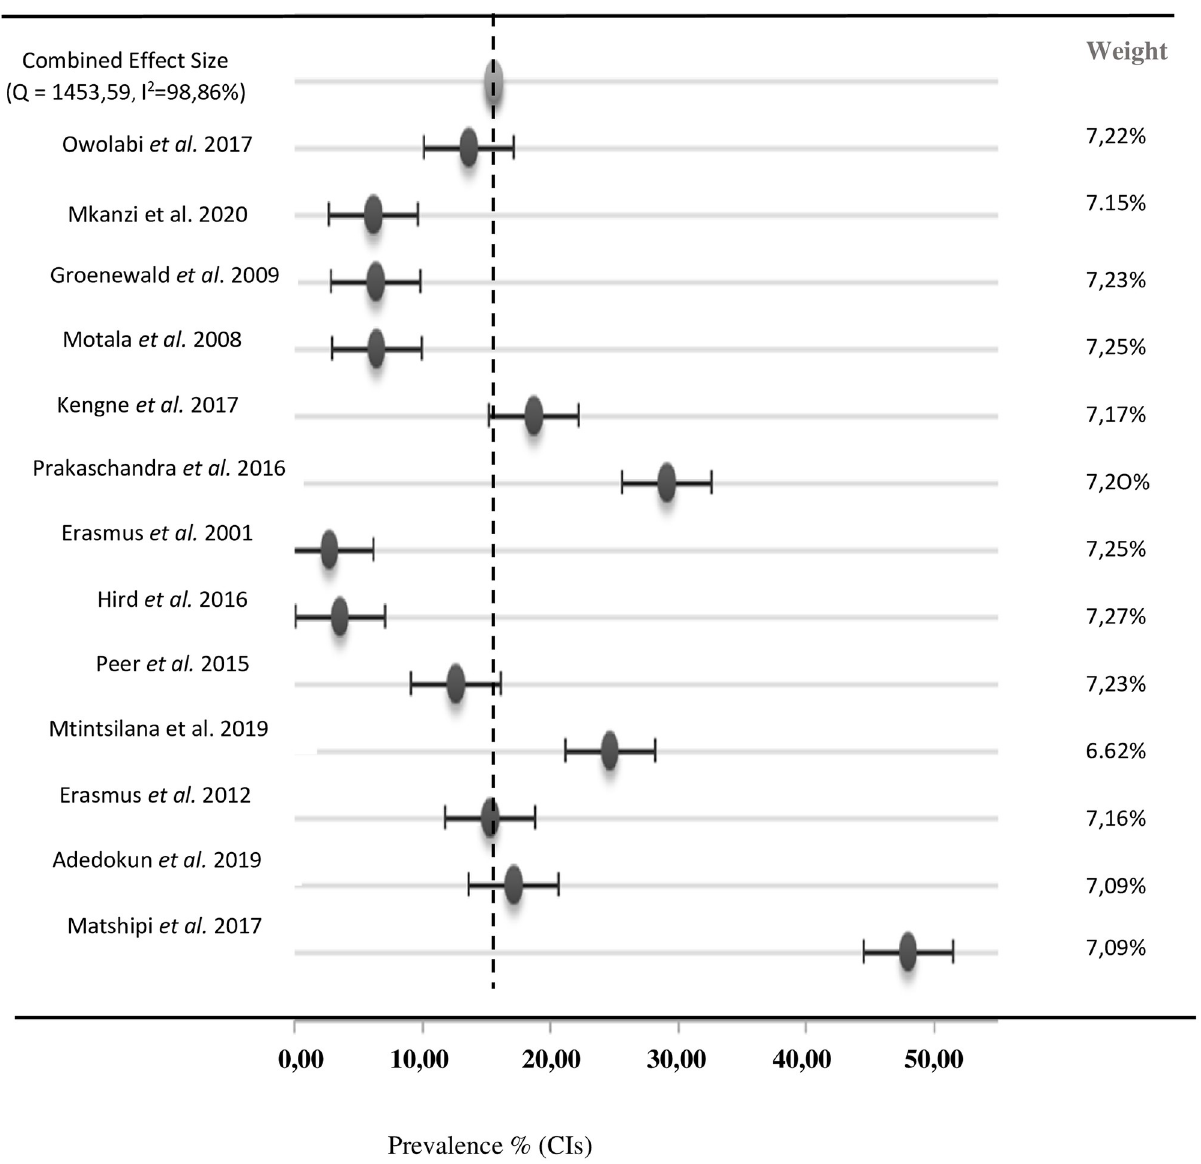
Fig 2. Presents a forest plot of the summary of the analysis of prediabetes prevalence in South Africa. The diagnosis was determined by either IFG or IGT test. In a pooled sample of 9339 participants, the prevalence of prediabetes was 15,56%, with a heterogeneity of